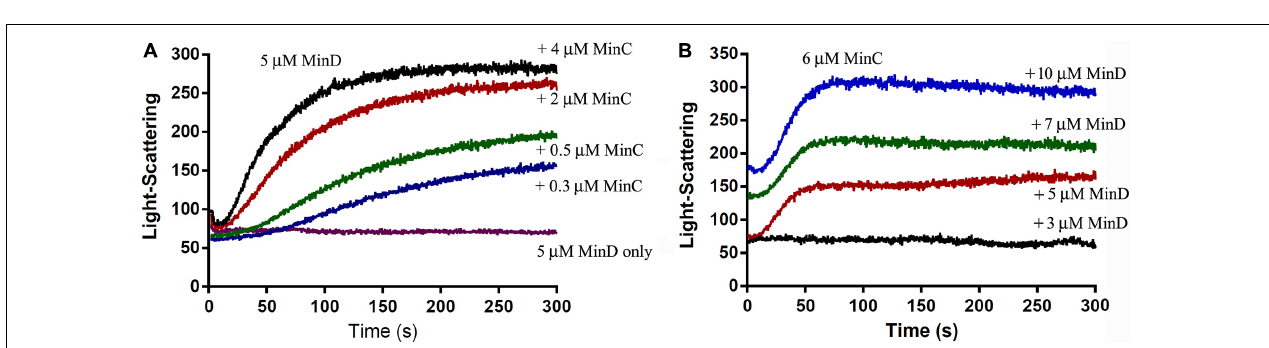
FIGURE 2 | BsMinC and BsMinD coassembled into a long and large bundle in the ratio of 1:1. (A) Negative stain EM showed that 8 µ M BsMinD and 4 µ M BsMinC coassembled into large bundles in the presence of 2 mM ATP. Bar represents 200 nm. (B) SDS-PAGE analysis of cosedimentation in different ratios of BsMinC and BsMinD showed that the ratio of BsMinC and BsMinD in the pellet is always approximately 1:1. The initial concentration of the mixture, the estimated MinC and MinD concentrations in the supernatant and pellet are presented at the bottom of the panel. S, supernatant; P, pellet.